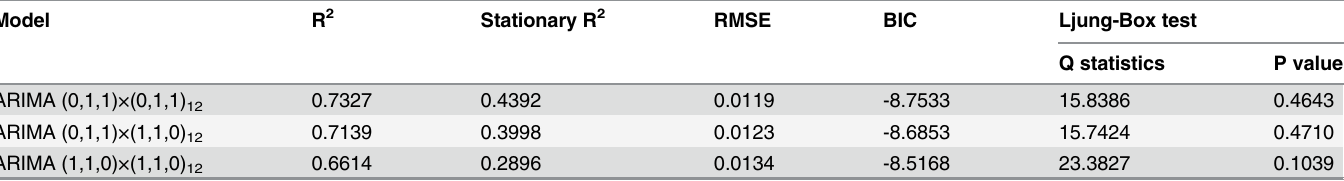
Table 1. Comparison of three candidate ARIMA models. Model